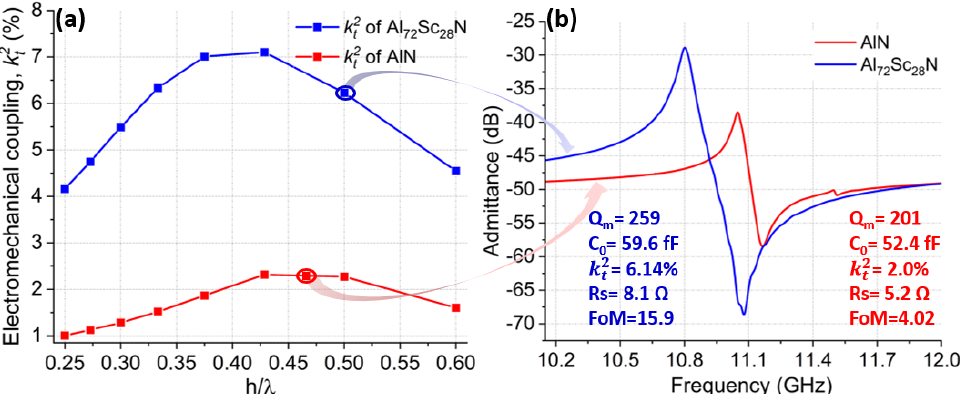
Figure 7. ( a ) Simulated k t 2 of AlN (red) and AlScN (blue) over a range of h / λ x values. ( b ) measured admittance response of AlN and Al 72 Sc 28 N CLMRs operating around 11 GHz with respective arrows indicating expected k t 2 values.